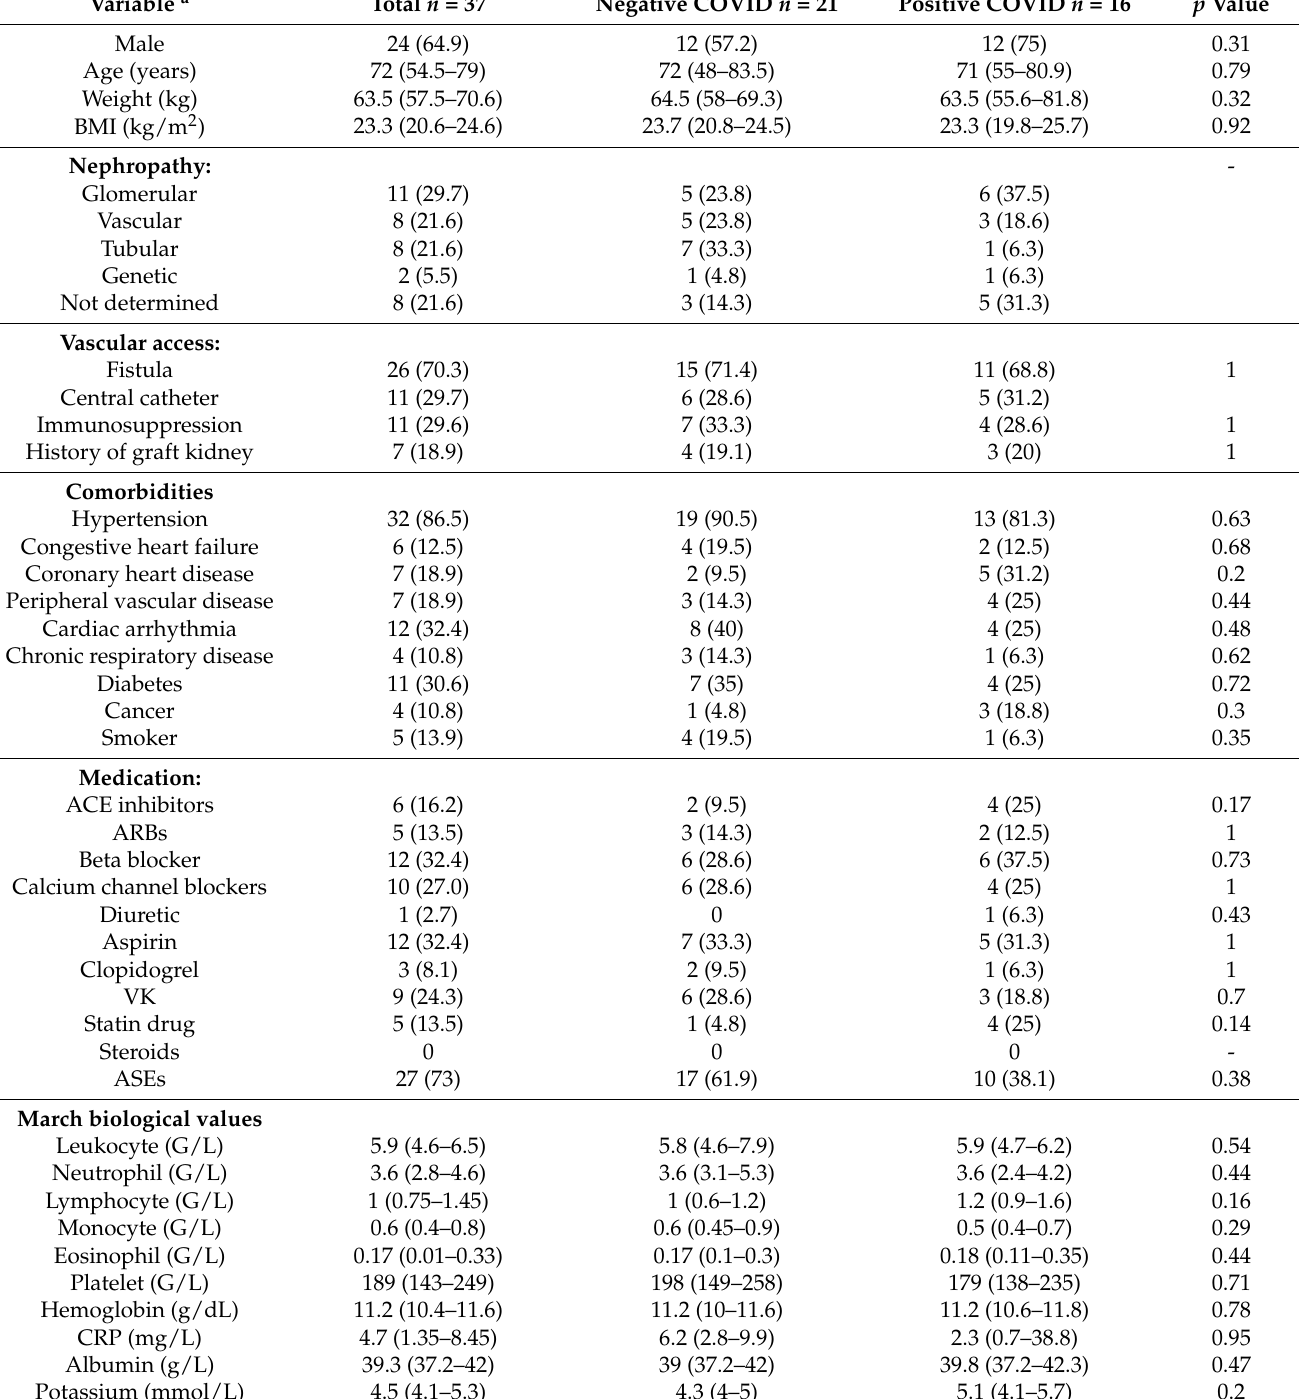
Table 1. Patients baseline